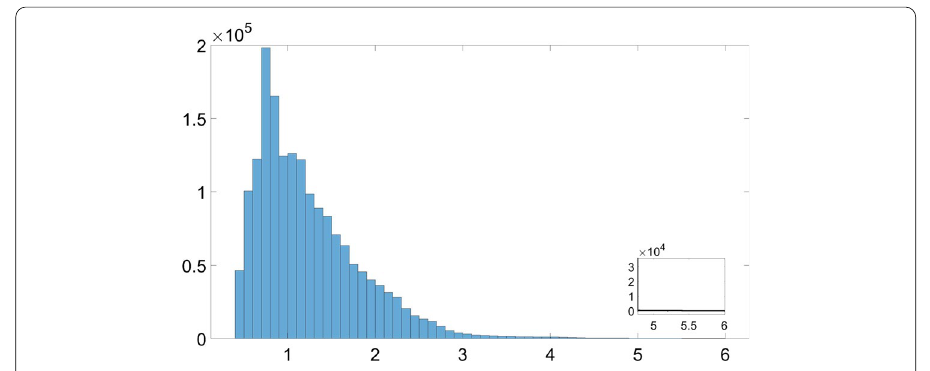
Fig. 1 The statistics of hourly electricity data